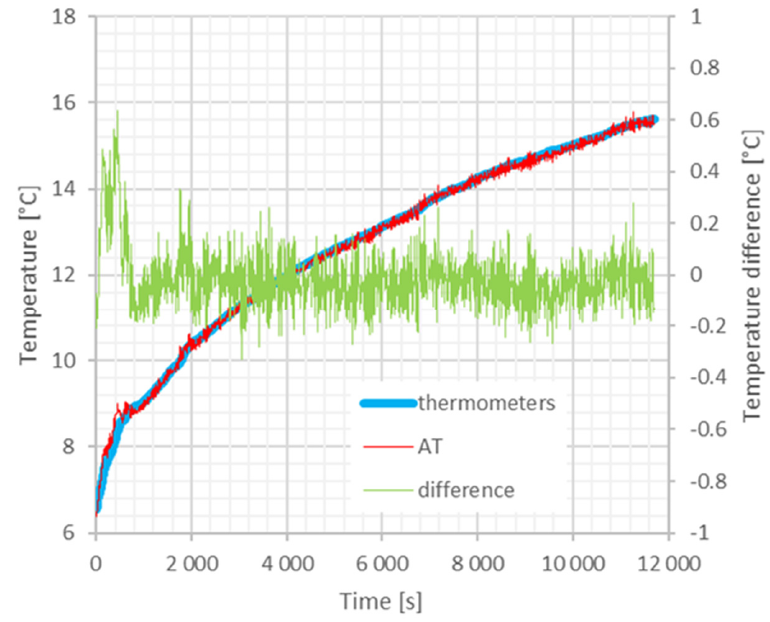
Figure 7. Comparison between the temperature measurement obtained by platinum thermometers and the acoustic thermometer over a 11 m distance. The blue curve is the mean of the temperature measured by the four thermometers placed along the path. The red curve is the temperature estimated from the speed of sound through the Cramer equation. Both curves refer to the left scale in °C. The green curve is the difference between the two referred to the right scale in °C. The maximum error occurs when the temperature change is faster and is due to the slow reaction time of the PT100 compared to the acoustic thermometer.